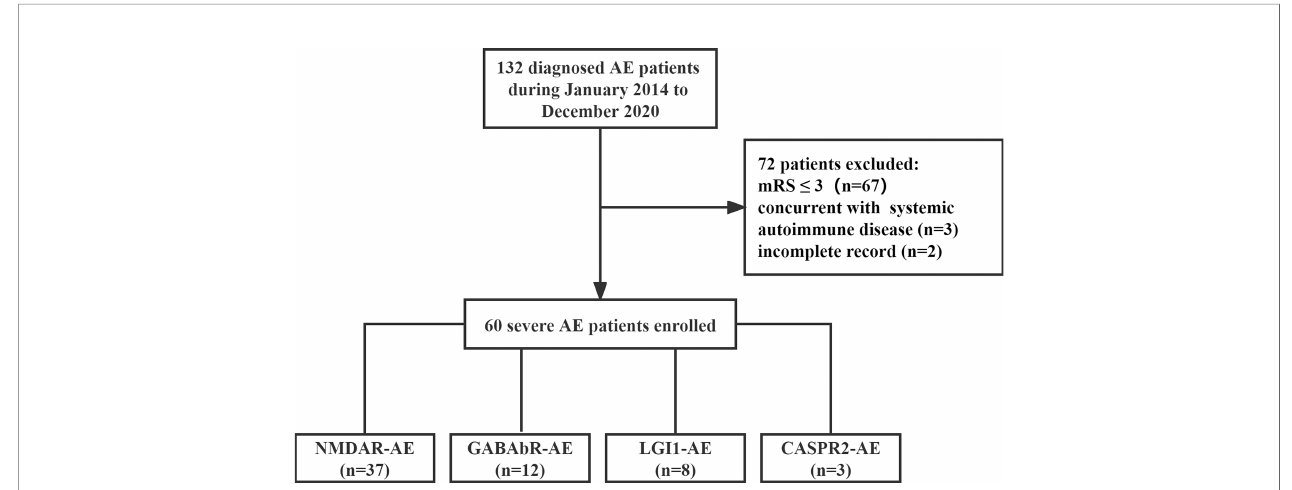
FIGURE 1 | The fl owchart of included